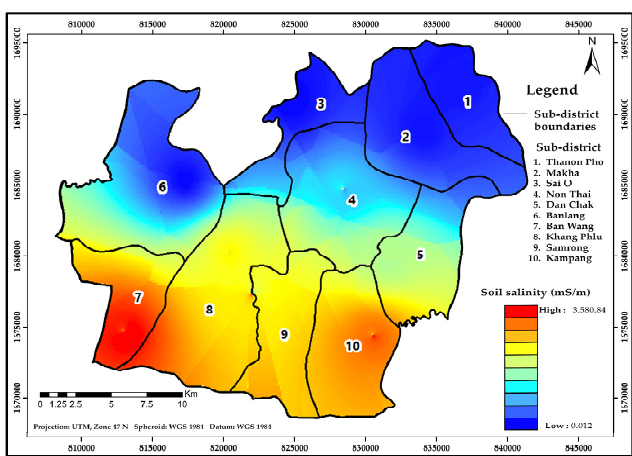
Figure 7. Spatial distribution of average ECe using the IDW method.